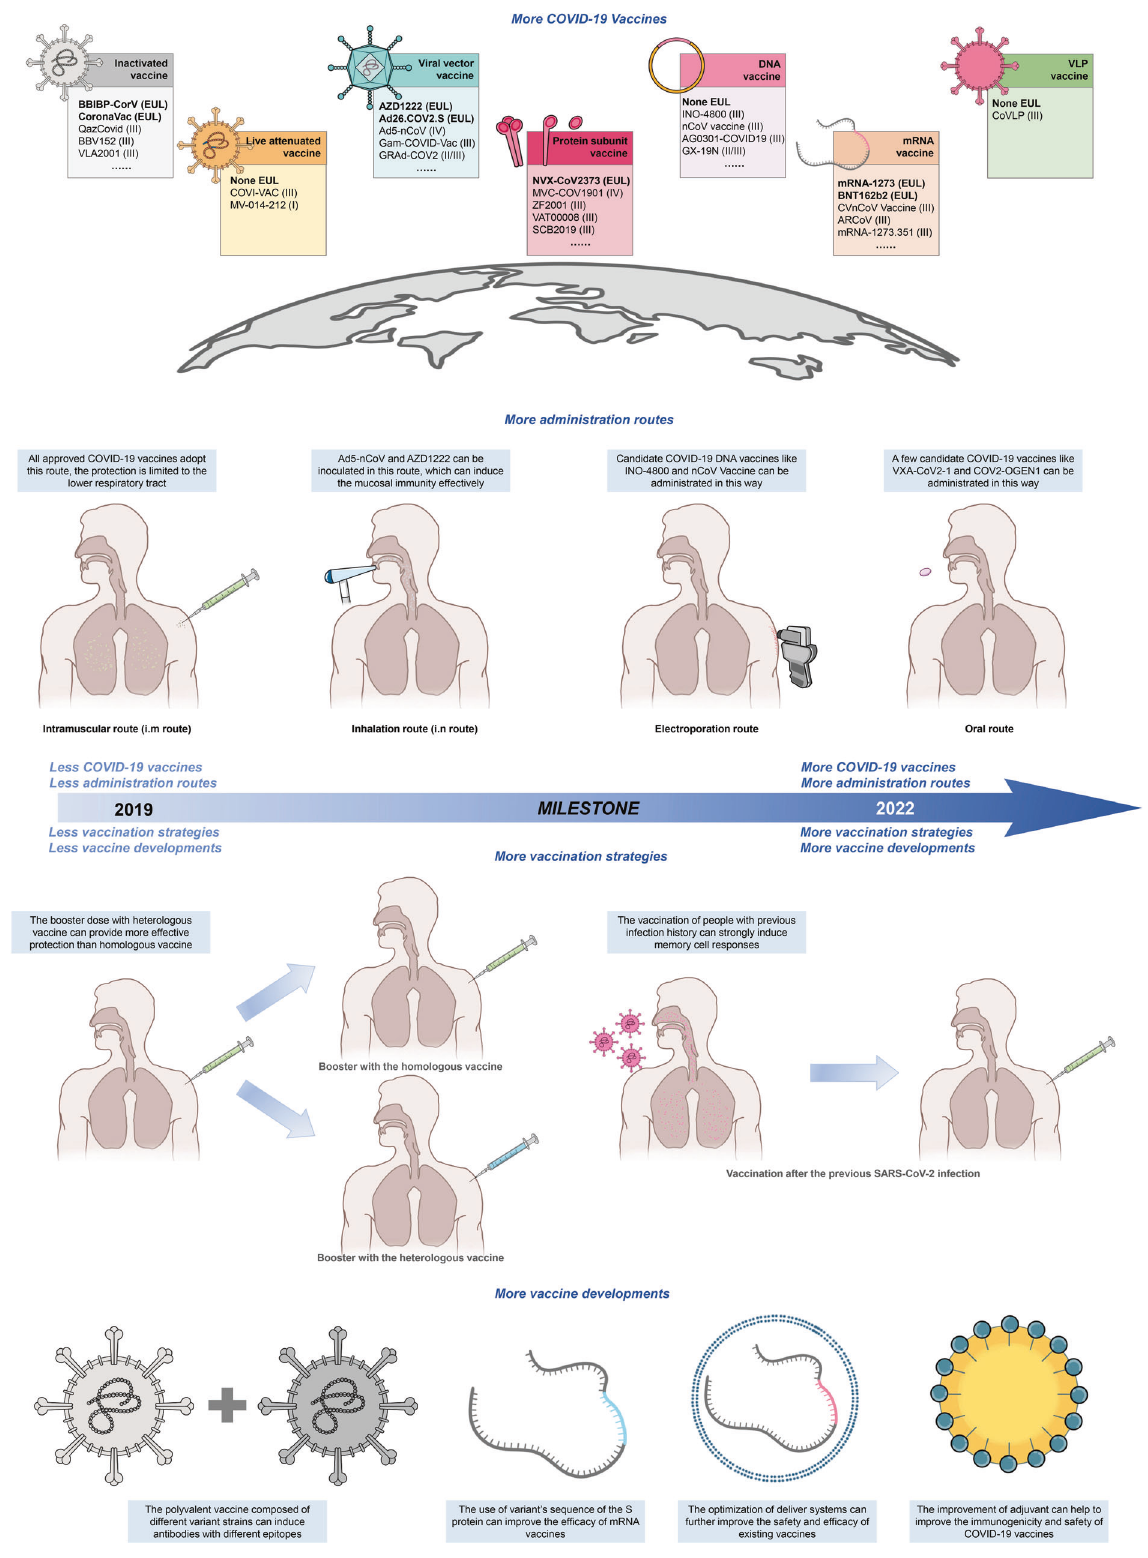
Fig. 1 The milestones of COVID-19 vaccine development. With the maturity of vaccine platforms, more and more COVID-19 vaccines have entered clinical trials and been approved for emergency use in many countries. However, the appearance of VOCs has brought great challenges to existing COVID-19 vaccines. By changing the administration route, the protection provided by vaccines can be enhanced, and more vaccination strategies are applied to cope with VOCs. In addition, more vaccine development methods are applied, such as developing polyvalent vaccines and improving adjuvant and delivery systems. These enormous changes form a milestone in the COVID-19 vaccine progress compared with